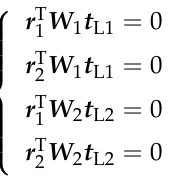
 t Figure 3. Process to solve (cid:101) t LR LR